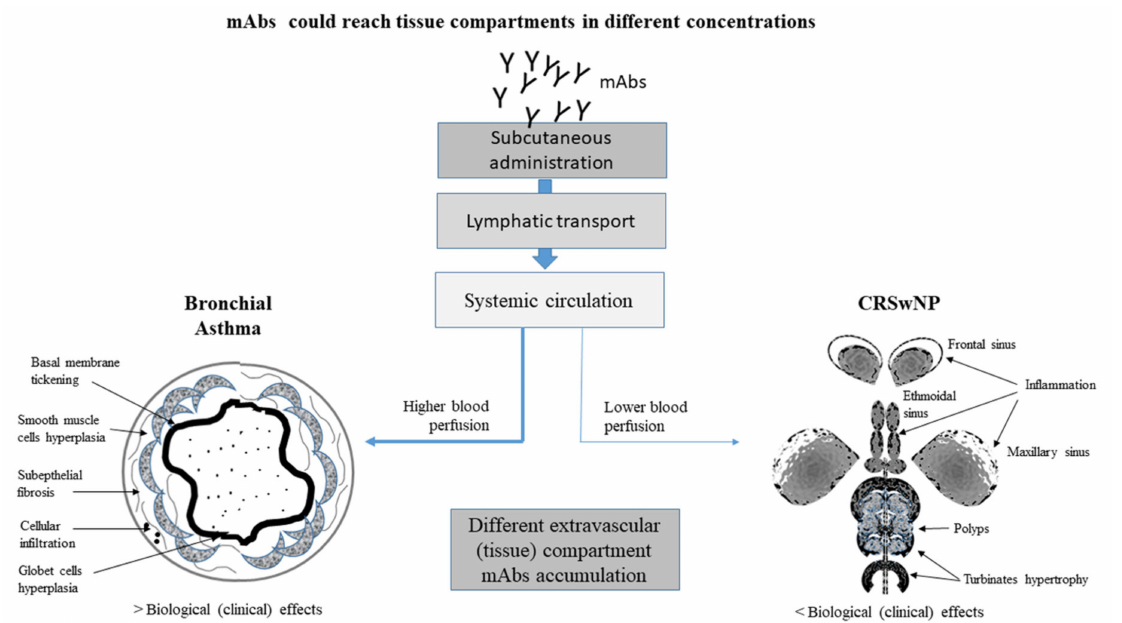
Figure 2. The mAb concentration at bronchial and nasal levels can be influenced by several factors, such as subcutaneous absorption, lymphatic transportation and different blood perfusion in the different organs and tissues, all conditioned by the chronic inflammatory process.